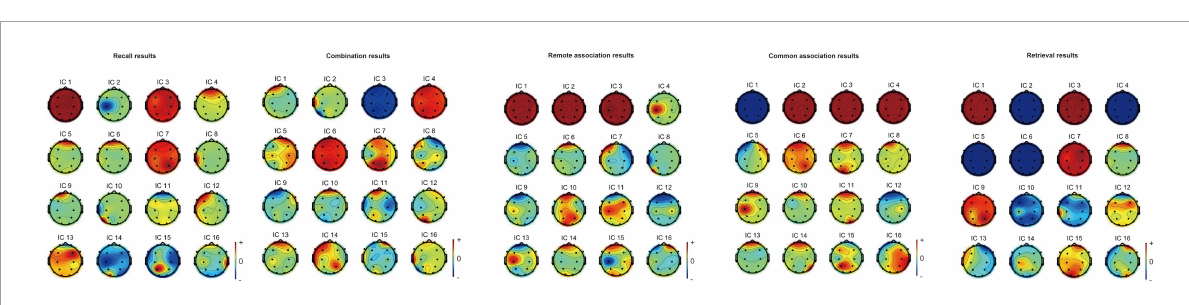
FIGURE4 ICA results for remote association, common association, recall, retrieval, and combination induction